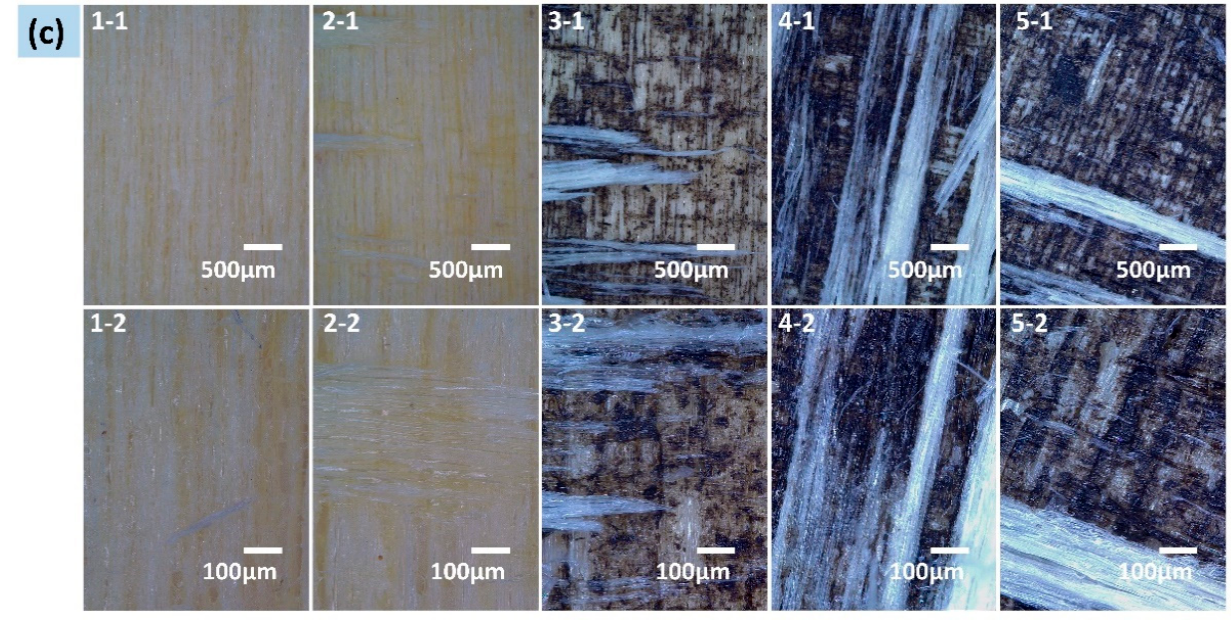
Figure 5. ( a ) Wet shear strength of different adhesives; ( b ) Comparison of the wet shear strengths and cross-linking agent concentrations between SPI/PAE/0.4%FGO and the other adhesives [15,20,46–54]; ( c ) Macro-surface morphology of the damaged plywood surface: 1-1,1-2: SPI adhesives, 2-1,2-2: SPI/PAE adhesives, 3-1,3-2: SPI/PAE/0.2% FGO adhesives, 4-1,4-2: SPI/PAE/0.4% FGO adhesives, 5-1,5-2: SPI/PAE/0.6% FGO adhesives.